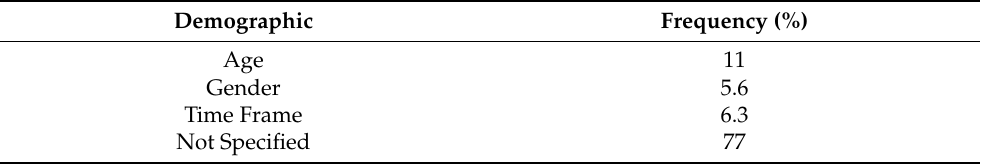
Table 5. Frequency of different demographics used in all the studies.